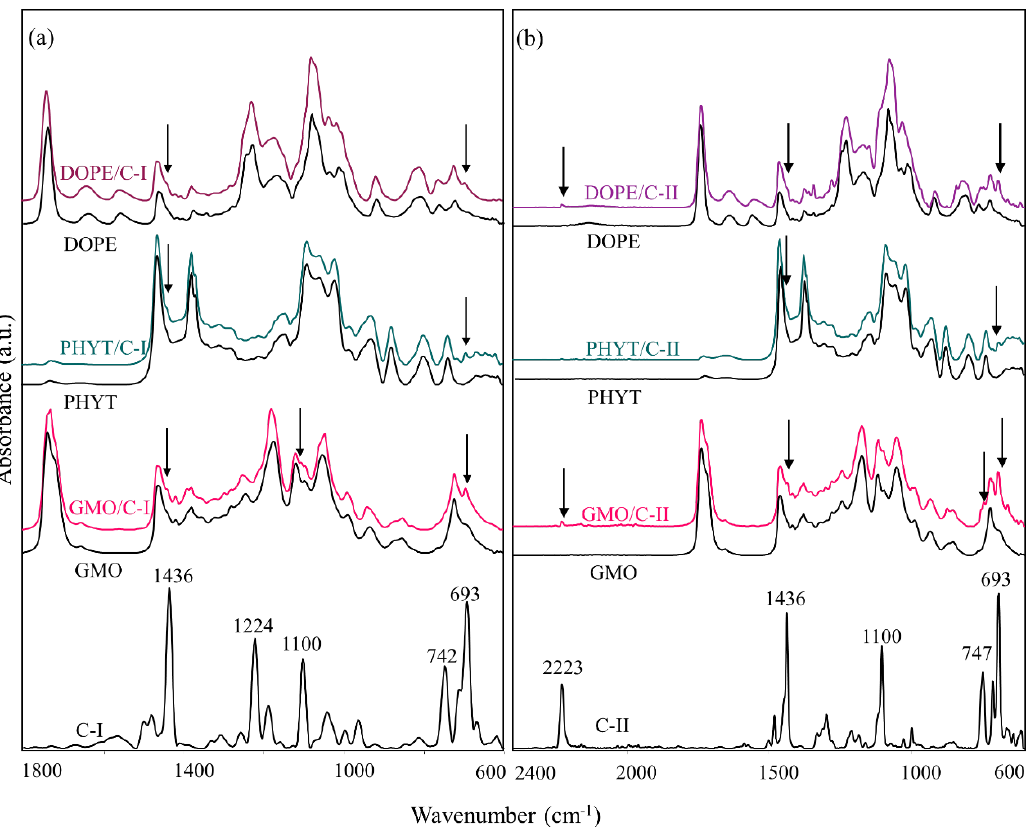
Figure 5. IR spectra of C-I (collected ( a ) and computed ( b ); 1800–600 cm −1 spectral range), and C-II (collected ( c ) and computed ( d ); 2400–600 cm −1 spectral range) drugs. The position (in terms of wavenumbers, cm −1 ) of the most significant peaks observed in C-I and C-II is shown.